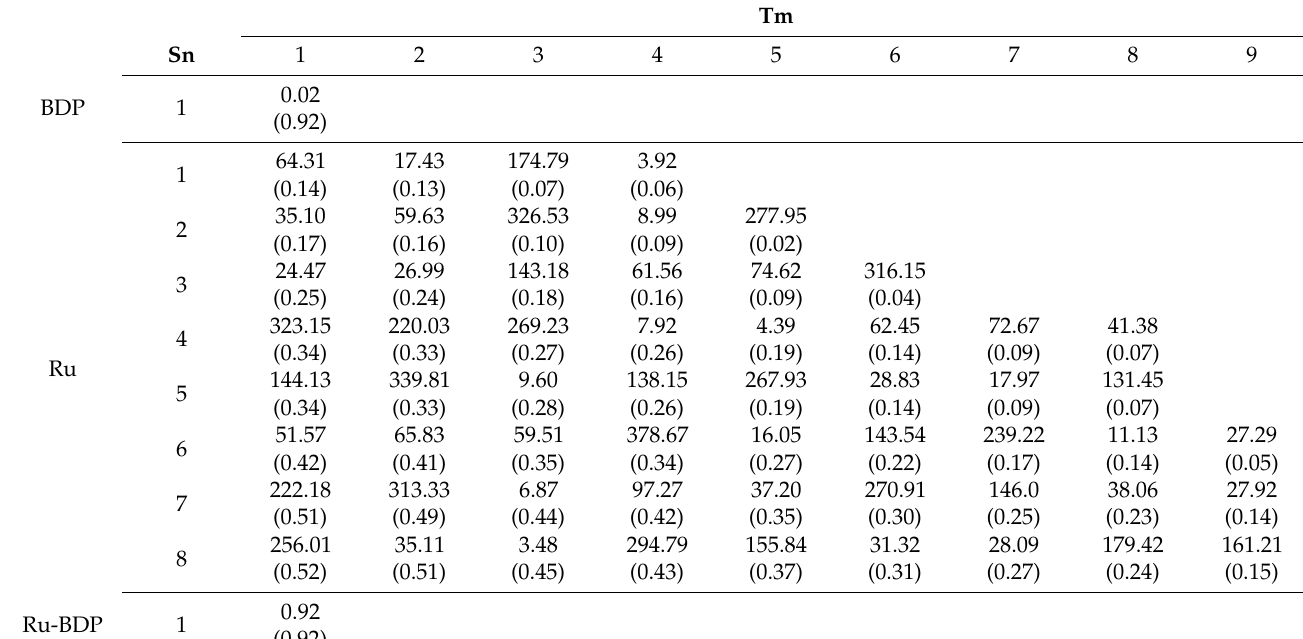
Table 3. Computed SOCs (cm − 1 ) for S n -T m radiationless transitions and singlet-triplet splitting energies, ∆ E (eV), between the involved states in